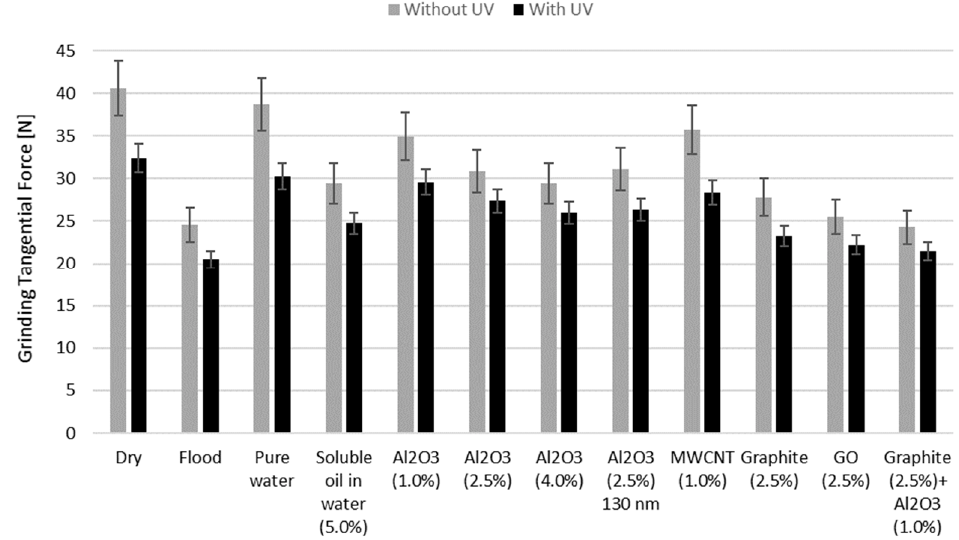
Figure 6. Effect of the presence of UV in MQL grinding on the tangential force.